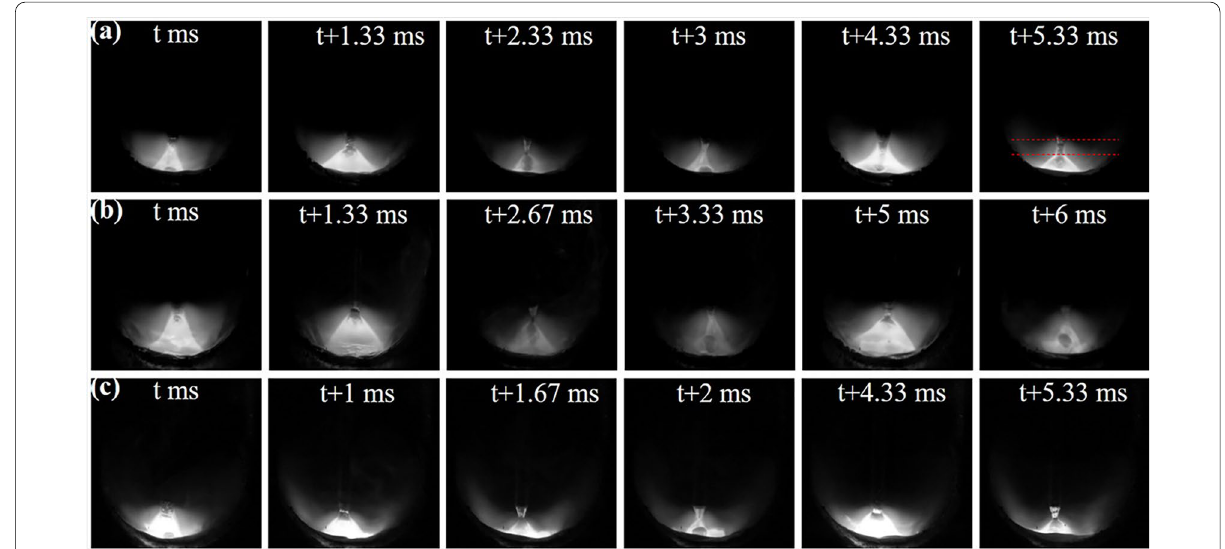
limits the droplet. So more attention is put on surface tension and electromagnetic force.